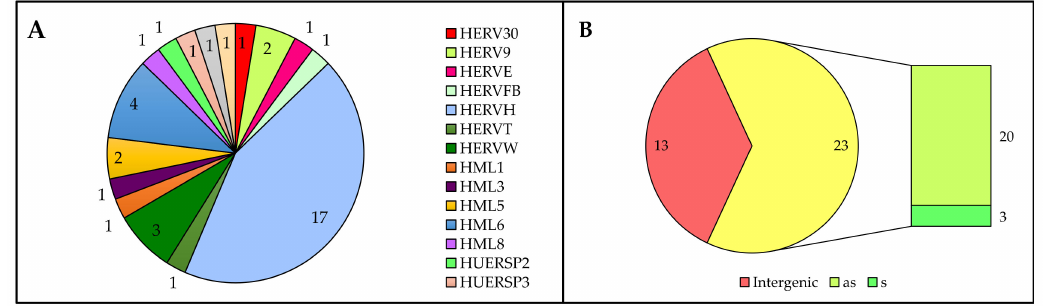
Figure3. OverviewoftheindividualHERVlocimodulatedinthepresenceofHIVinfection. ( A )Number of HERV loci for each group; ( B ) Genomic context of integration: for intragenic HERVs (yellow) the sense (s) or antisense (as) orientation with respect to the surrounding gene is also